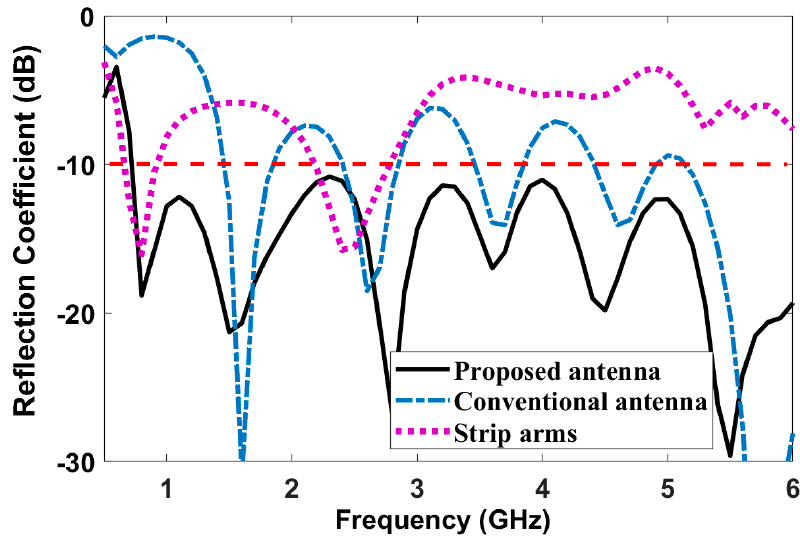
Figure 5. Reflection coefficient of the AVA structure with arms (proposed antenna) and without arms (conventional antenna), and only strip arms.